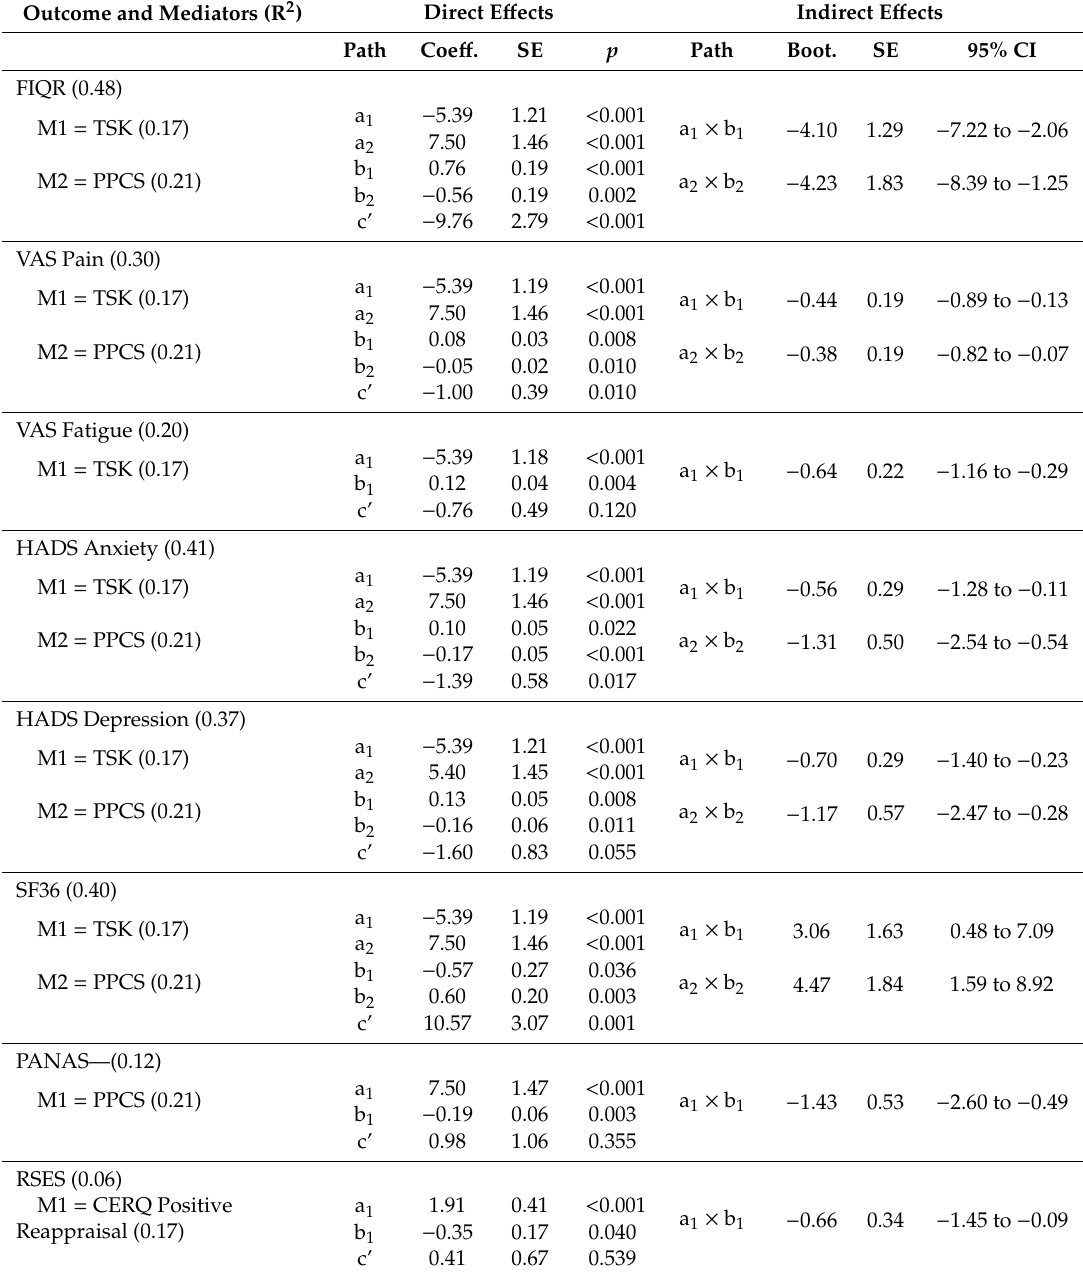
Table 6. Direct and bootstrap indirect e ff ects in the multiple mediational models of TAU + NAT-FM vs. TAU (e ff ects of pre- to mid-treatment changes in process variables on pre-to-post changes in primary and secondary